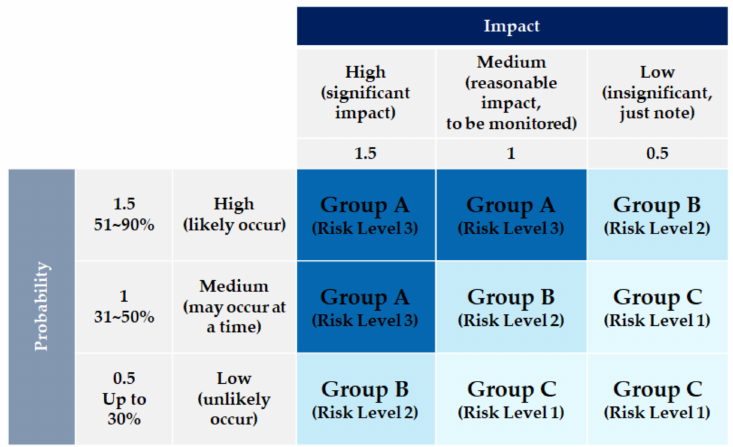
Figure 7. Impact matrix for classifying technical risk